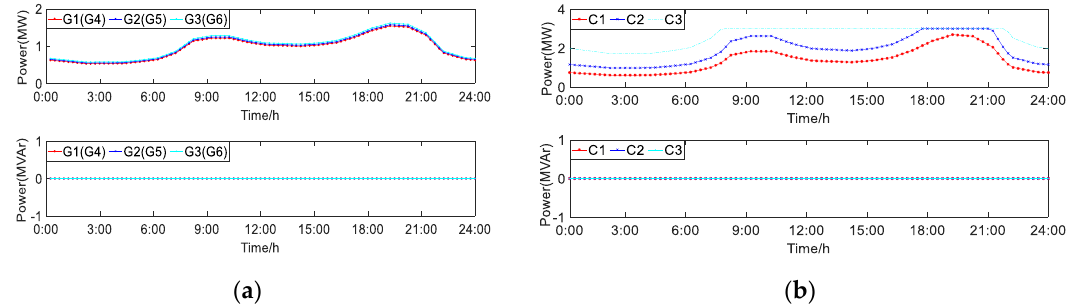
Figure 9. Centralized optimization of unit output. ( a ) Active and reactive power output of thermal power units. ( b ) Active and reactive power output of the CHP unit.